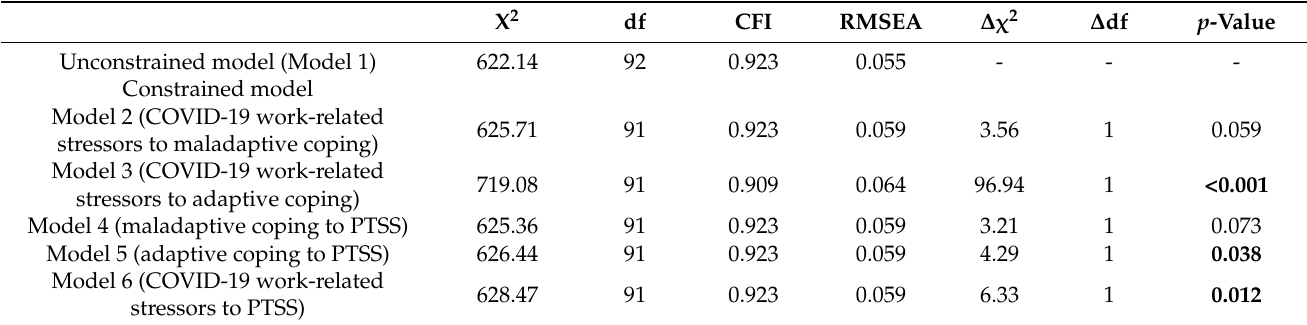
Table 4. Results of multi-group structural equation modeling by levels of perceived family